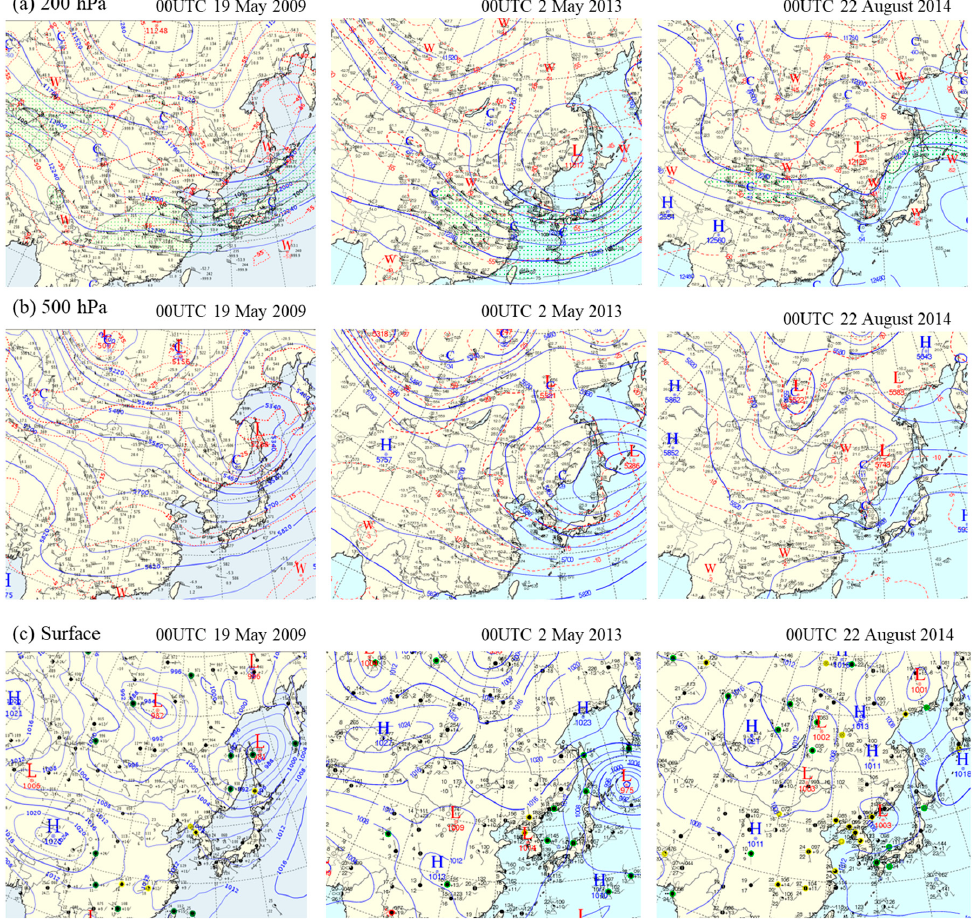
Figure 8. Synoptic weather maps of ( a ) 200 hPa, ( b ) 500 hPa, and ( c ) surface at 00:00 UTC 19 May 2009, 2 May 2013, and 22 August 2014, respectively.